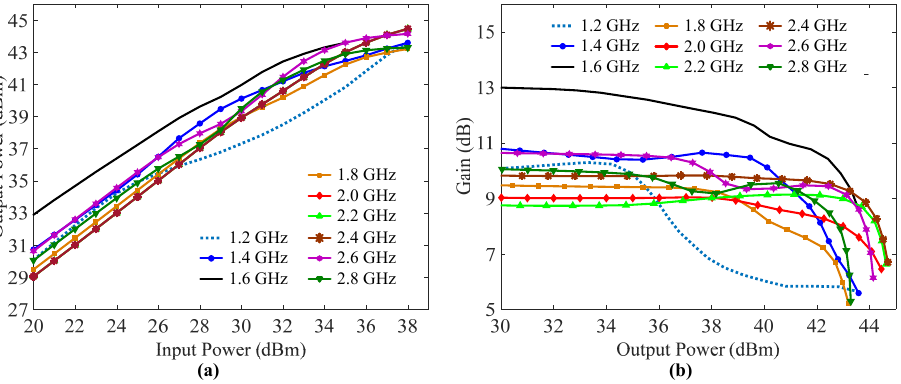
Figure 11. Measured ( a ) output power and ( b ) gains of the fabricated DPA at different